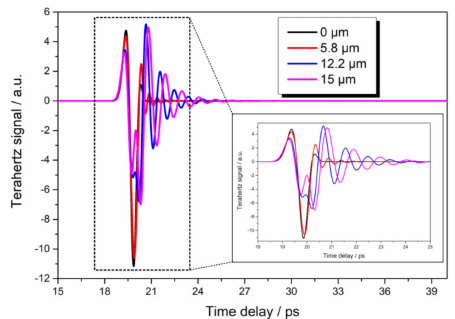
Figure 2. Terahertz finite di ff erence of time domain (FDTD) simulated signals from four di ff erent samples (0, 5.8, 12.2, and 15 µ